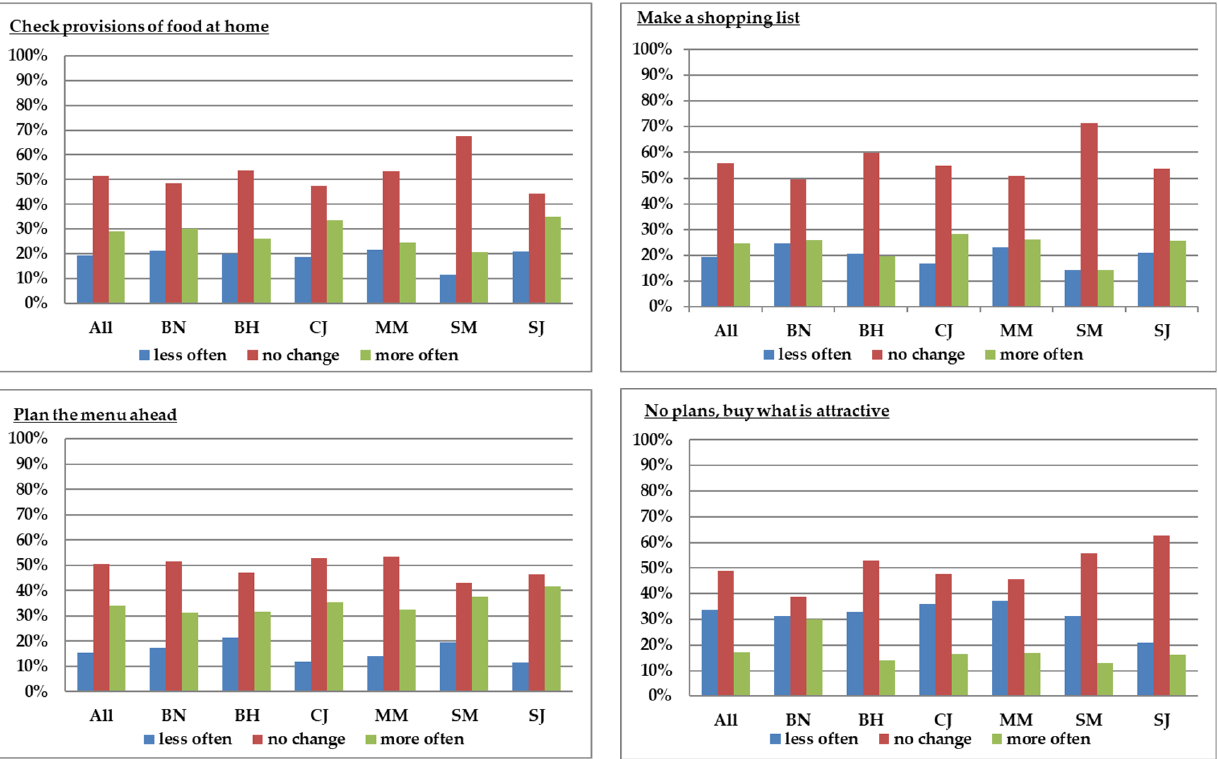
Figure 2. Shopping habits during the pandemic as compared to the pre-COVID-19 period (BN: Bistrita-Nasaud, BH: Bihor, CJ: Cluj, MM: Maramures, SM: Satu-Mare, SJ: Salaj).